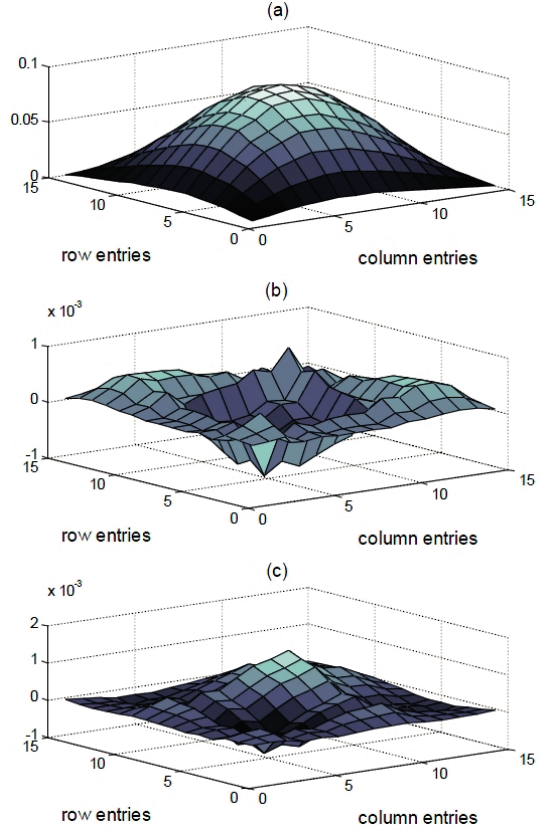
Figure 10. Plots of the matrices for the ( a ) fl exibility of the intact specimen ( b ) differences in the fl exibilities corresponding to IC and DC1, and ( c ) differences in the fl exibilities corresponding to IC and